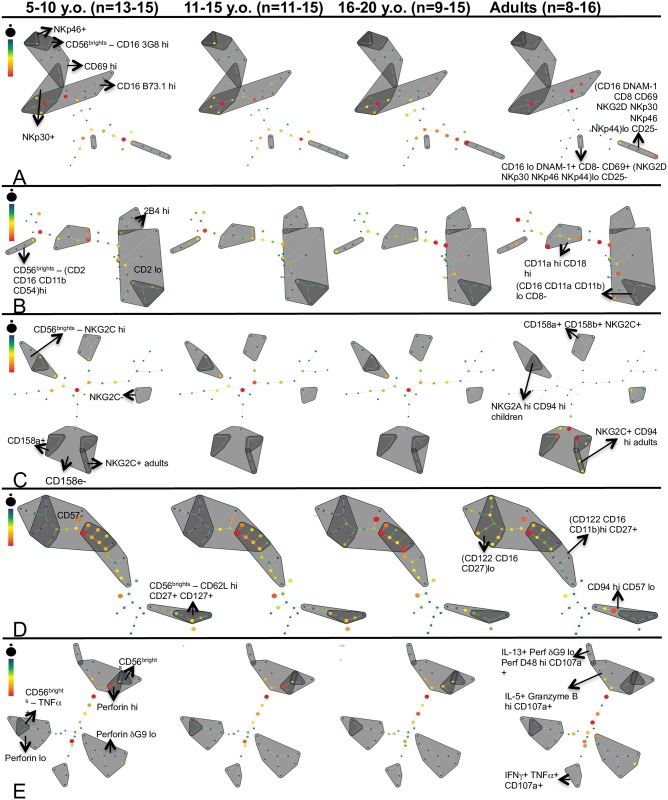
Clustering analysis of NK cell subsets using SPADE demonstrates phenotypic differences in healthy adults and children.Each SPADE plot illustrates the concatenated NK cell data from several individuals and each node corresponds to the percentage of NK cells. Color of each node represents signal intensity (see scale) and size represents frequency. The regions of the plot (grey) were characterized by sequentially defining expression of each panel marker by signal intensity in separate SPADE plots. Individual markers defining entire regions are shown in the leftmost plot and combinatorial NK subset regions are indicated in the rightmost plot. (A) NK cells expressing activating receptors without stimulation among 5–10 y.o. (n = 15), 11–15 y.o. (n = 15), 16–20 y.o. (n = 15) and adults (n = 8) respectively. (B) NK cells expressing adhesion/ stimulatory receptors among 5–10 y.o. (n = 14), 11–15 y.o. (n = 14), 16–20 y.o. (n = 15) and adults (n = 12) respectively. (C) NK cells expressing inhibitory receptors among 5–10 y.o. (n = 15), 11–15 y.o. (n = 15), 16–20 y.o. (n = 15) and adults (n = 16) respectively. (D) NK cells expressing developmental markers among 5–10 y.o. (n = 13), 11–15 y.o. (n = 11), 16–20 y.o. (n = 9) and adults (n = 12) respectively. (E) NK cells expressing cytokines and effector molecules without stimulation among 5–10 y.o. (n = 15), 11–15 y.o. (n = 15), 16–20 y.o. (n = 15) and adults (n = 8) respectively.